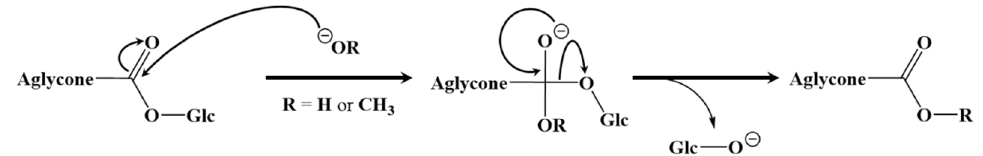
Figure 6. Mechanistic proposal for the hydrolysis (HO − ) and transesterification (CH 3 O − ) reactions undergone by the bidesmosidic saponins extracted from the quinoa husk: addition–elimination mechanism specifically occurring at the ester function.